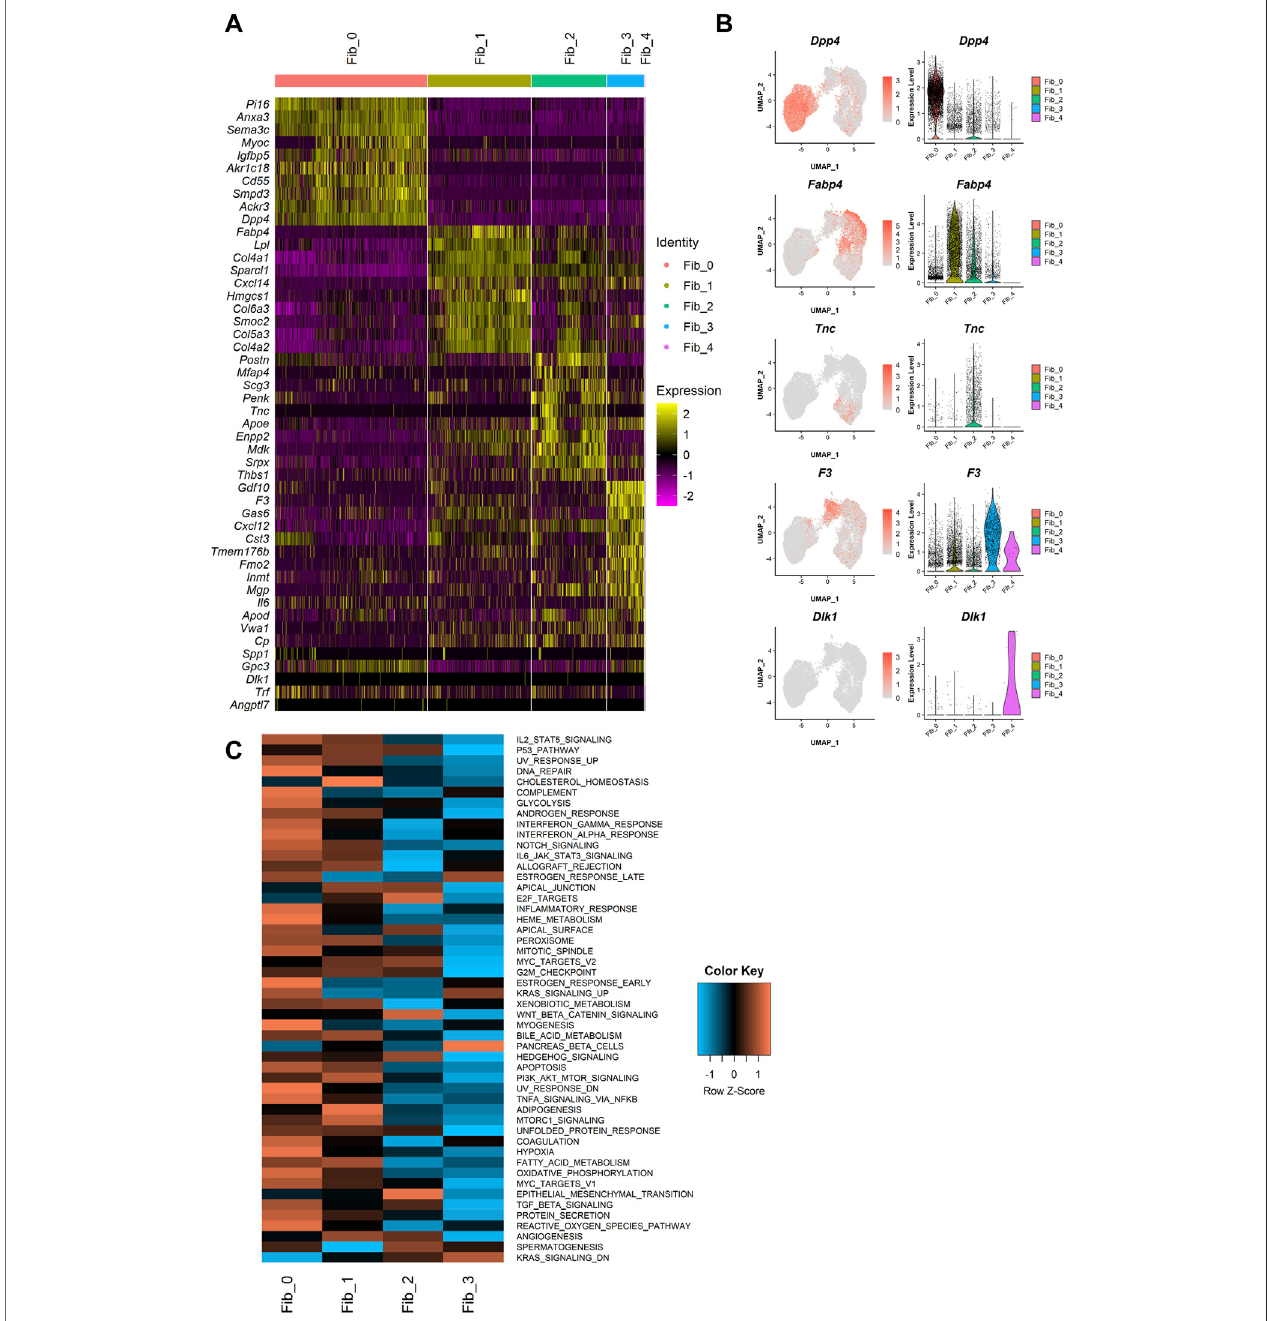
FIGURE 2 | Characterization of the mammary gland fi broblast populations identi fi ed by the unbiased clustering. (A) The heatmap of the top 10 DEGs for each cluster. Each column represents each cell and each row represents each gene. Log-normalized gene count was scaled per gene. Color bar at the top indicates the cell clusters identi fi ed in Figure 1B . (B) The expressions of the identi fi ed marker genes for each cluster. Each feature plot on the left panel shows the distribution of the marker-expressingcellswithcolorindicatingtheexpressionlevel.Eachviolinplotontherightpanelshowstheexpressionlevelofeachgeneineachcluster. (C) The heatmap of average ssGSEA scores for the hallmark gene sets in each cluster. ssGSEA score for each gene set was calculated from the log-normalized gene counts in each cell using the GSVA R package. Each row represents each gene set and each column represents the mean ssGSEA score for each cluster in each column. Color indicates the Z-score calculated by row.